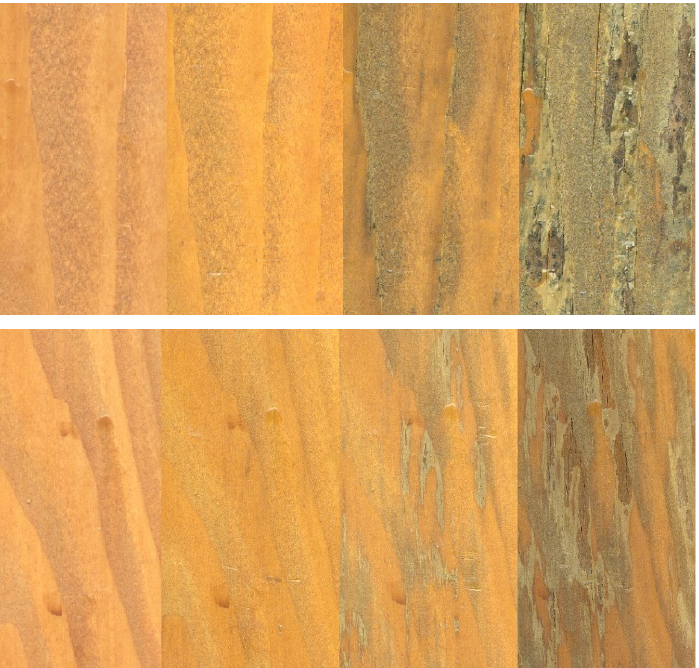
Figure 8. Examples of the same Douglas fir wood specimen treated with S1 and exposed outdoors on a test fence near Corvallis, OR, for 0, 6, 12, and 18 months ( top row ) and a similarly treated sample exposed at Madras, OR, for 0, 6, 15, and 25 months ( bottom row ).